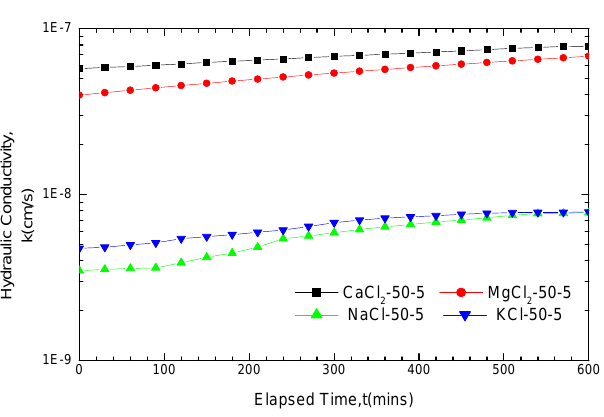
Figure 2. Hydraulic conductivity results for GCL specimens soaked with 50 mM solutions for five days and permeated with the same solutions after soaking.